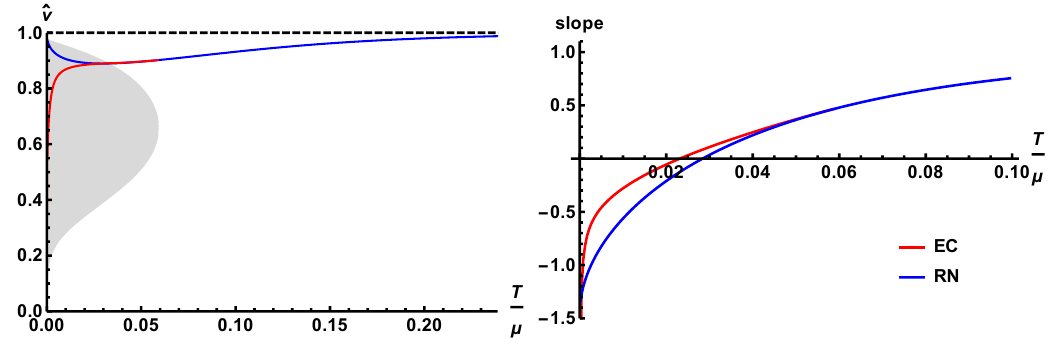
Figure 7 . Left : the curves indicate where the shadow region starts in our electron cloud back- ground (red) and in AdS -Reissner-Nordström background (blue). The black dashed line indicates 4 the black hole horizon. The gray area shows the size and position of the bulk charges of the elec- tron cloud. Right : the asymptotic slope of the generalized functional in the limit of large strip width (4.11). In the Reissner-Nordström case, the slope approaches unity at high temperatures be- cause the shadow approaches the event horizon where the weighting function ˆ γ (ˆ v ) vanishes leaving only the area contribution in